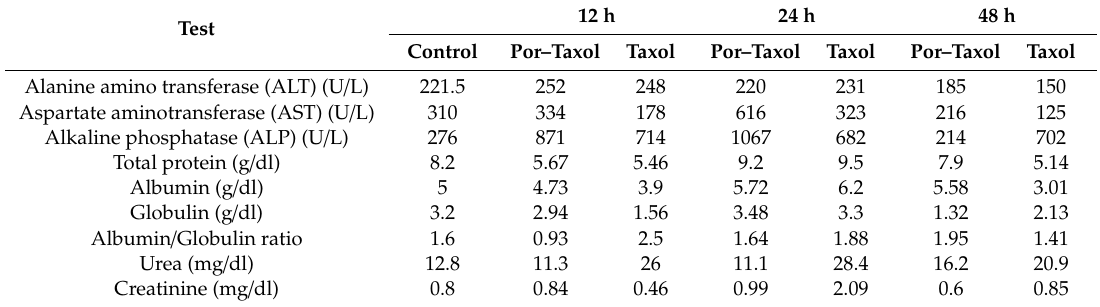
Table 1. Biochemical analysis of mice in response to Taxol and porphyrin–Taxol conjugates